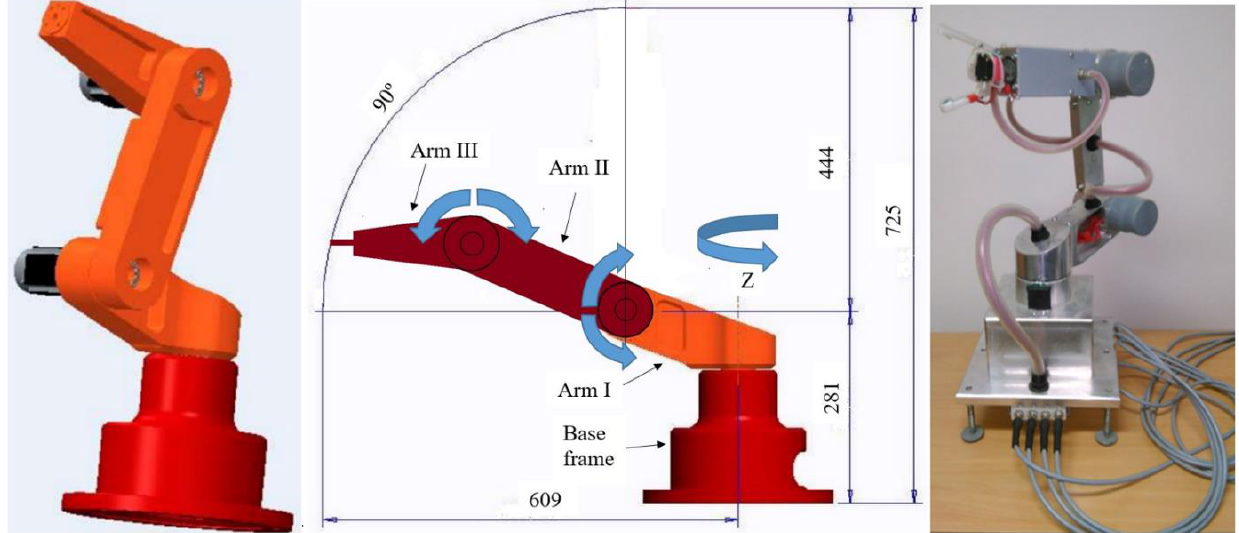
Figure 1. Robot with angular workspace (dimensions in mm).